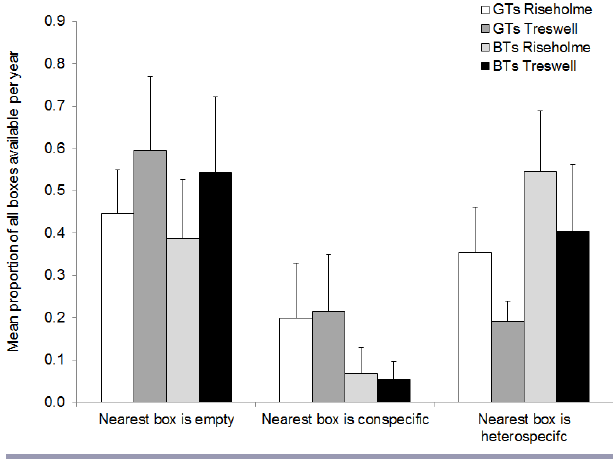
Fig. 2 . Mean (+SD) proportions of the nest boxes that contained either no bird, a conspecific, or a heterospecific for Great Tits ( Parus major ) and Blue Tits ( Cyanistes caeruleus ) nesting at Riseholme Park or Treswell Wood.